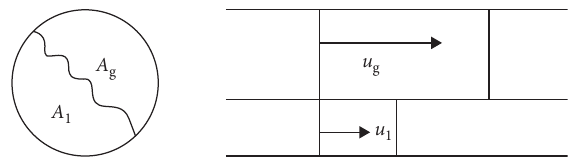
Figure 1: Two-phase and separated-flow model.